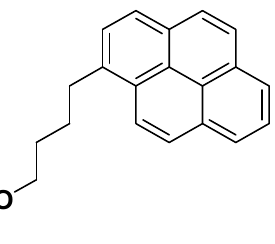
Figure 1. Structures of pyrene